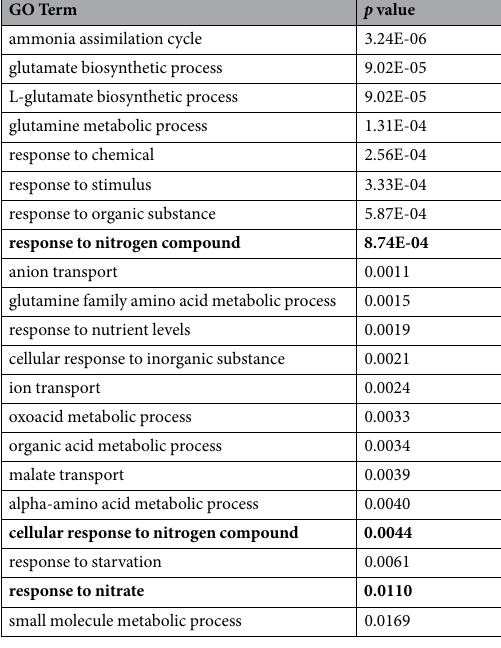
Table 4. GO analysis for the genes regulated only by NRT1.1 after nitrate treatment.